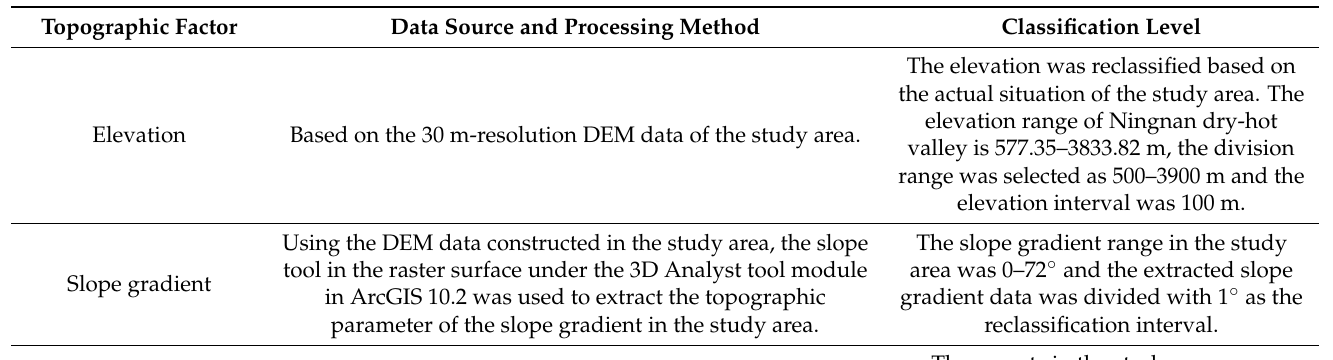
Table 1. Topographic factor extraction method and classification